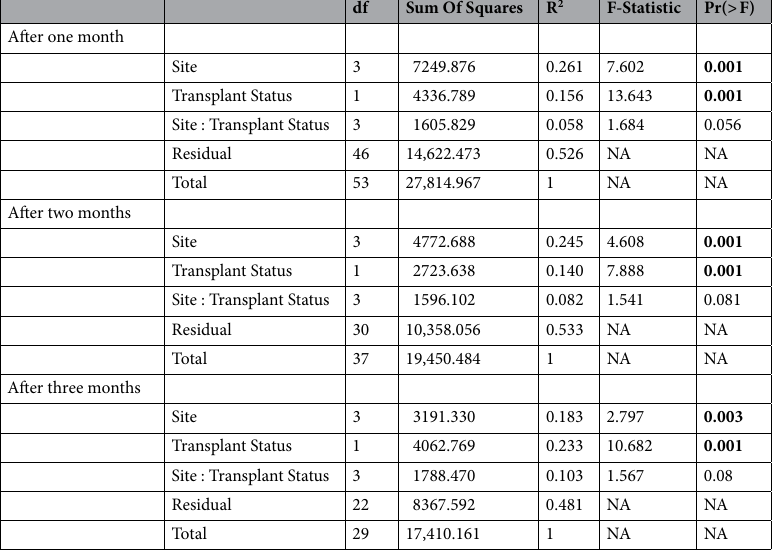
(Fig. 4D–F; negative binomial GLM, p destination = 0.007, p origin = 0.023, p destination:origin = 0.447; significant pairwise differences: p destination CCvsWP = 0.011, p destination MMvs WP , p origin MMvsWP = 0.023). Similarly, there were no differences in ASV richness among control and transplanted roots (ANOVA negative binomial GLM, p 1 = 0.071, p 2 = 0.572, p 3 = 0.984) (Supplemental Fig. S8D–F), and variance within transplanted plants was typically the same as for the untransplanted control plants, except at three months (ANOVA, p = 0.164, p 2 = 0.108, p 3 = 0.0009).